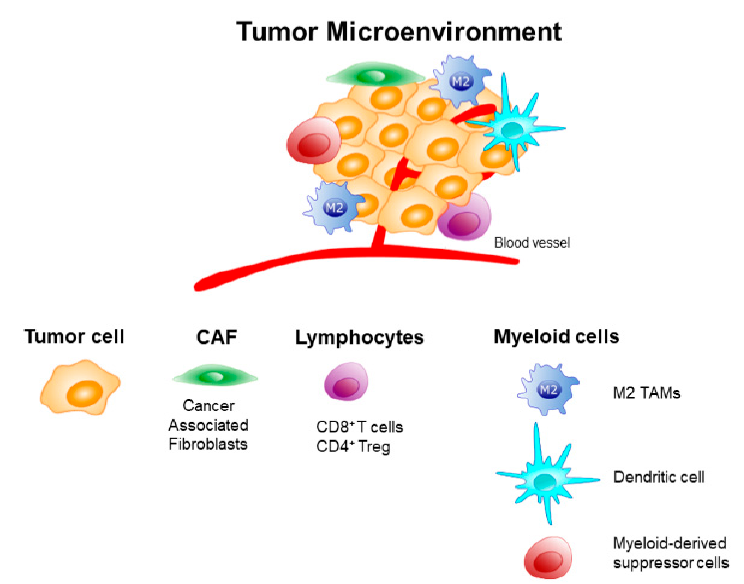
Figure 2. Schematic representation of cells populating the tumor microenvironment (TME).